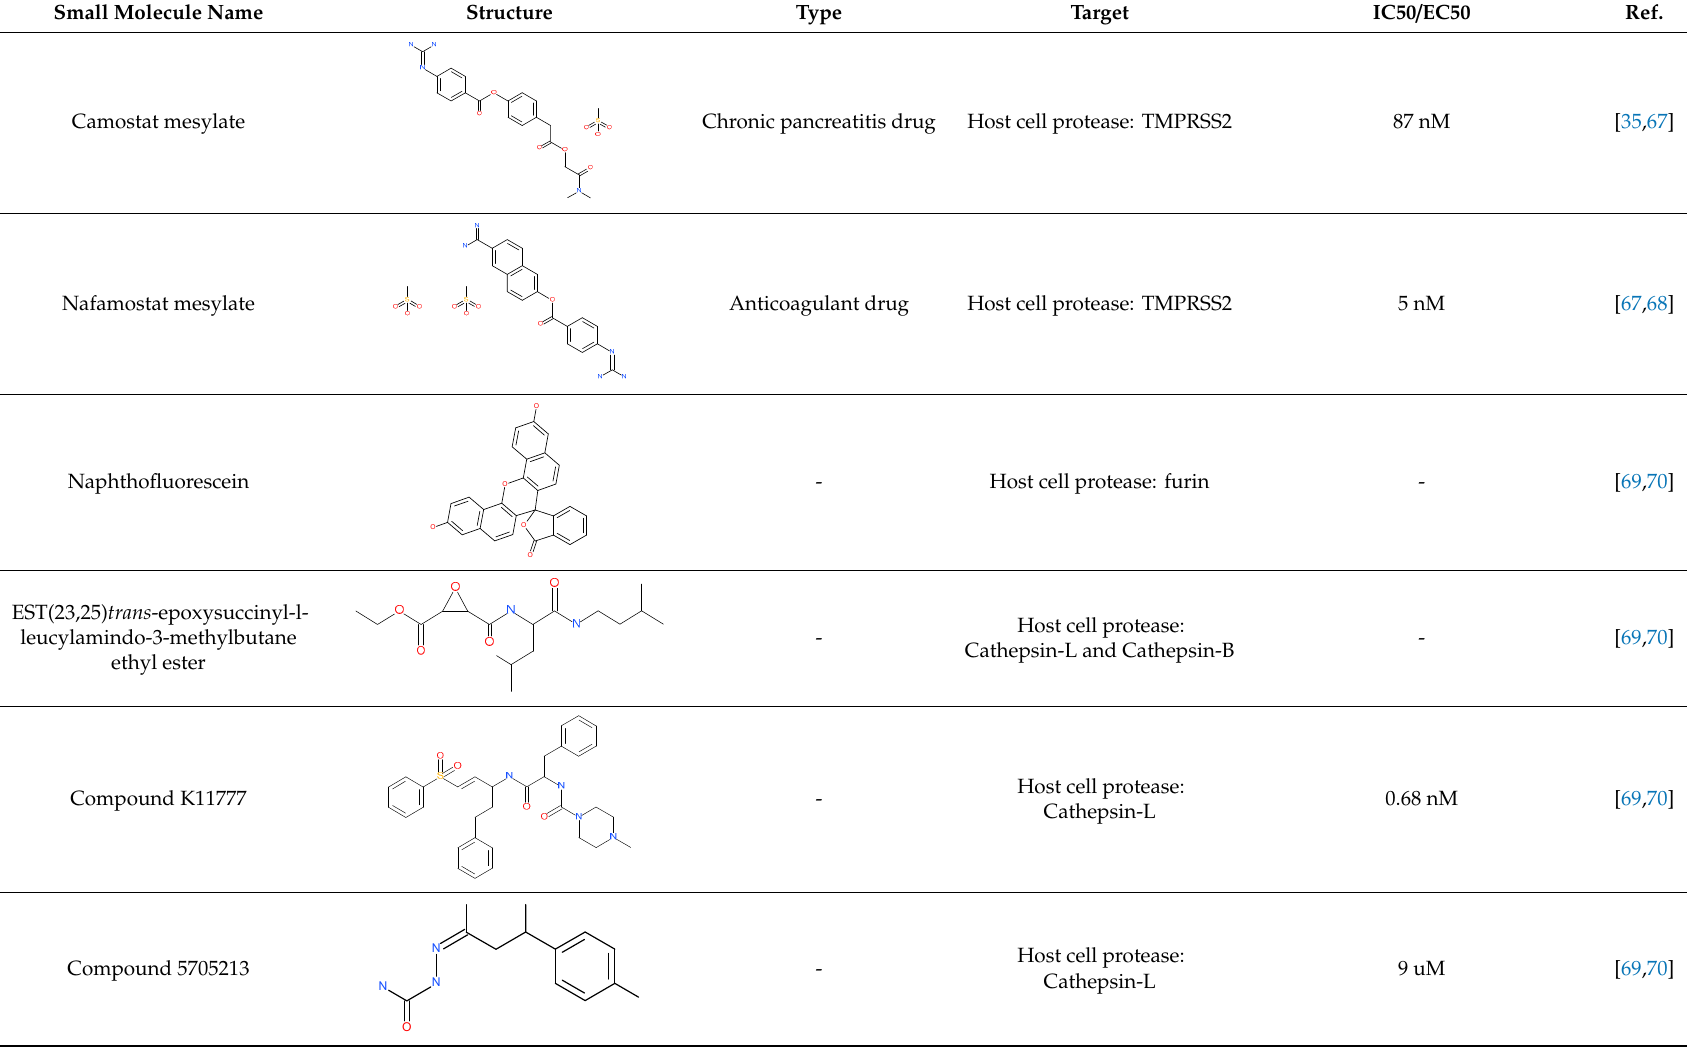
Table 4. Small molecules identified through experimental approaches for targeting host cell proteases and ACE2.